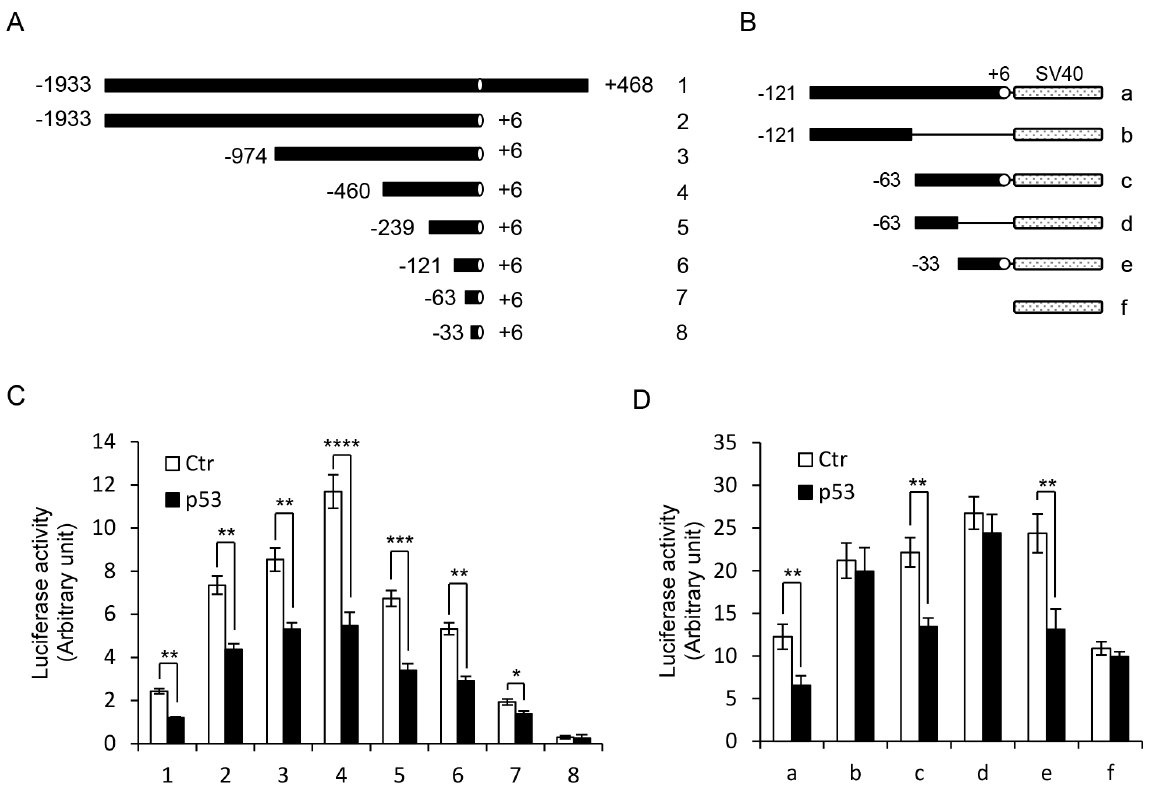
Figure 4. Mapping of the GFI1 promoter region required for p53-mediated repression. (A and B) Schematic diagrams of GFI1 promoter fragments cloned into pGL3-basic vector (A) or inserted upstream of the SV40 promoter of the pGL3-promoter vector. (C and D) p53 2 / 2 HCT116 cells were transfected with the indicated GFI1 promoter luciferase reporter constructs without or with p53. Luciferase activities were measured 36 hrs after transfection.